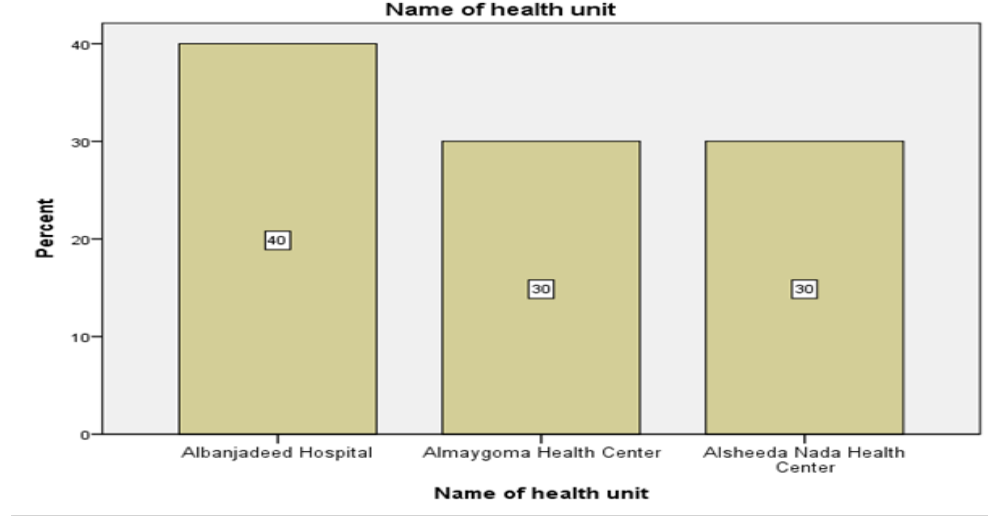
Figure 1. Distribution of samples collected according to the health centers .